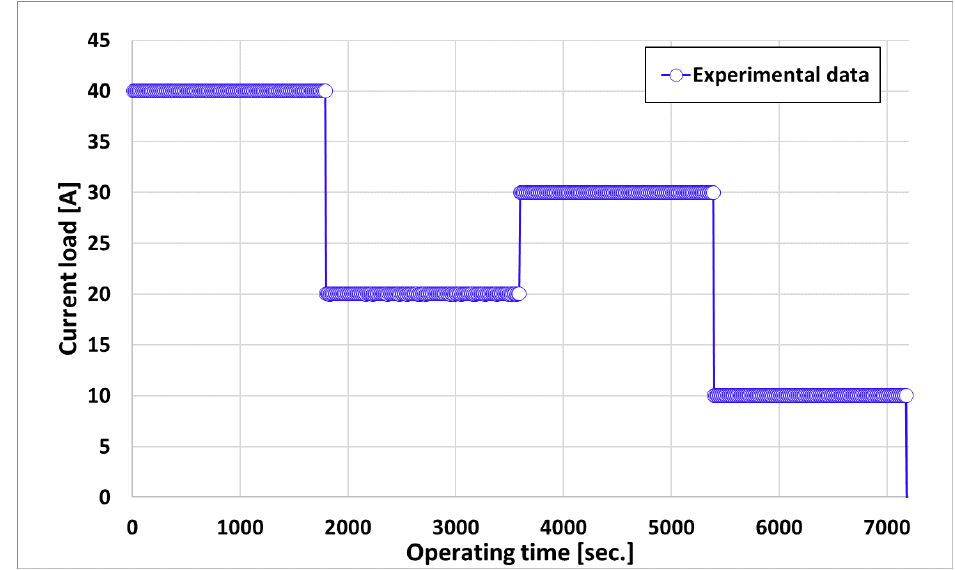
Figure 4. Current load profile of the dynamic condition.